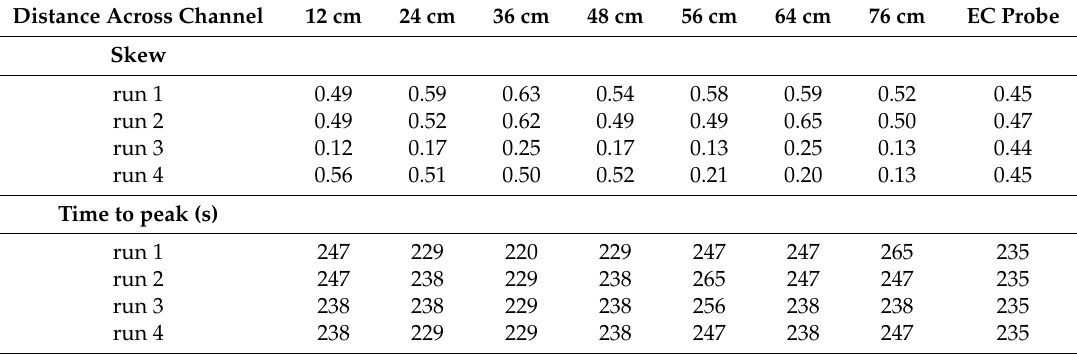
Figure 12. ( a ) Rennbach-Koulbich mixing zone cross-channel tracer concentration profile. Red line is data converted from the mid-channel EC probe; ( b ) Tracer concentration versus time contours across the Rennbach-Koulbich mixing zone transect. Table 6. Rennbach-Koulbich mixing zone. Tracer results for skewness and time to peak. Distance Across Channel